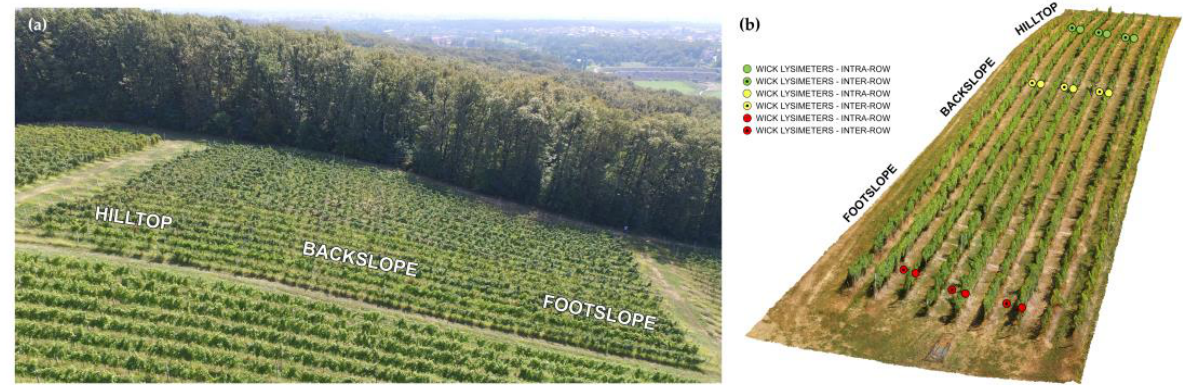
Figure 1. ( a ) Segments (i.e., hilltop, backslope, and footslope) of SUPREHILL critical zone observatory experimental vineyard plot, and ( b ) 3D model of SUPREHILL observatory with wick lysimeters installation points.